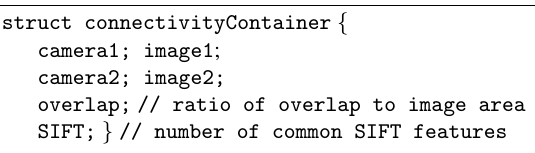
Algorithm 3: Connectivity container struct